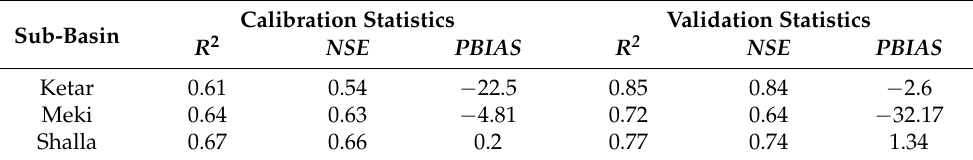
Table 7. Model performance statistics for the Ketar, Meki, and Shalla sub-basins.